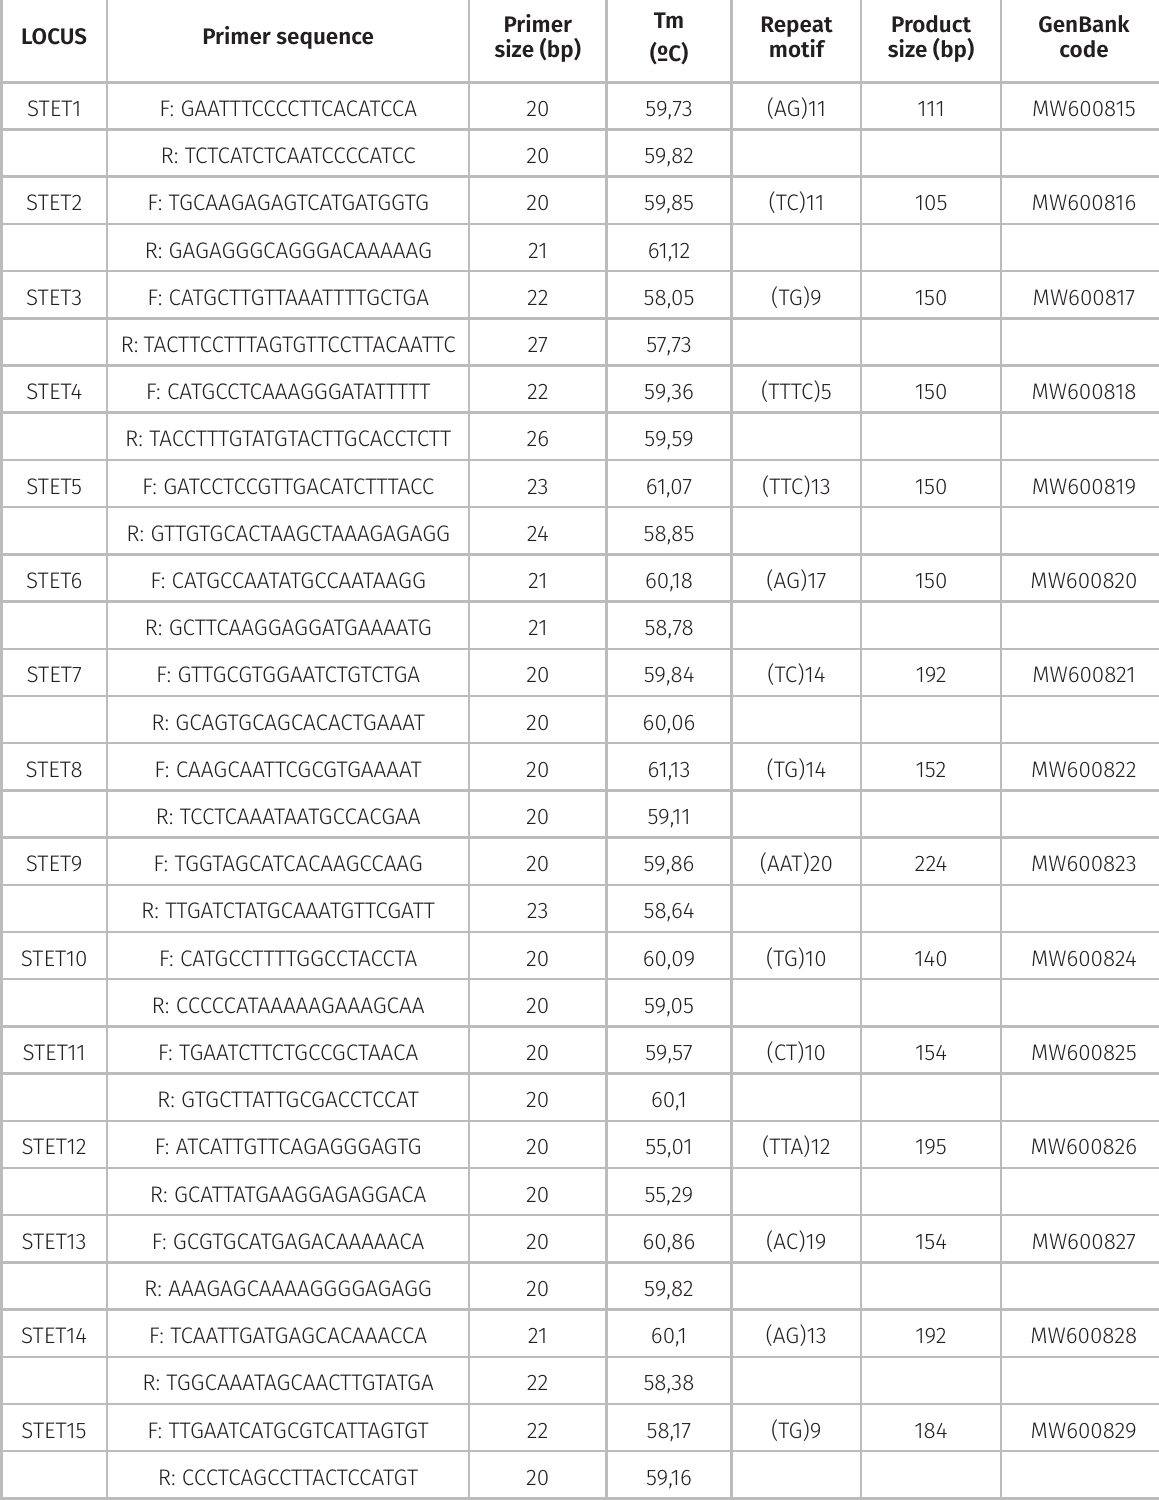
Table II. Characteristics of the 15 polymorphic microsatellite loci developed for Stetsonia coryne .